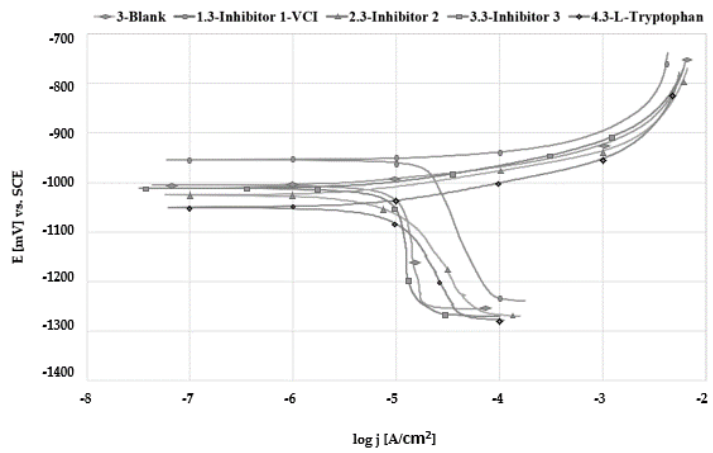
Figure 6. Polarization curves of tested inhibitors, compared to unprotected galvanized steel in 1% NaCl solution.